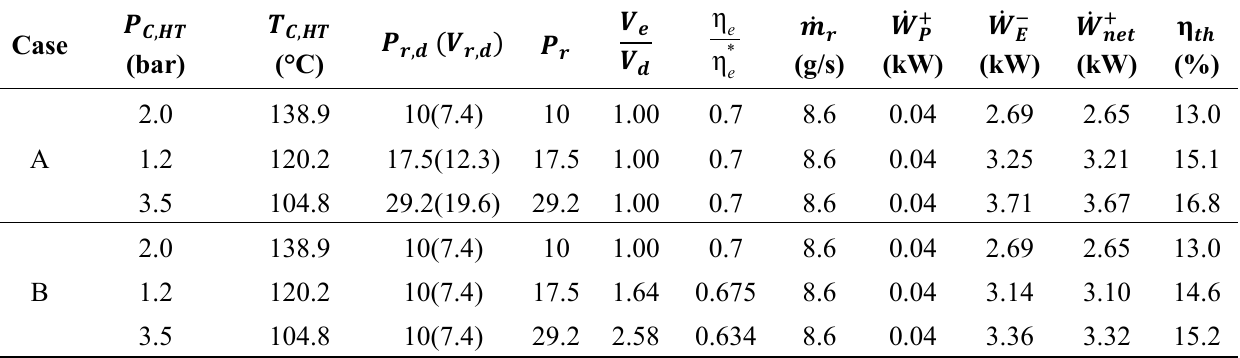
Table 1. Operation characteristics of the high-temperature (HT) cycle (A) with varying expander P r , d (= P r ) and decreasing T C , HT and (B) for the under-expansion state with P r , d fixed to 10, varying P r , and decreasing T C , HT